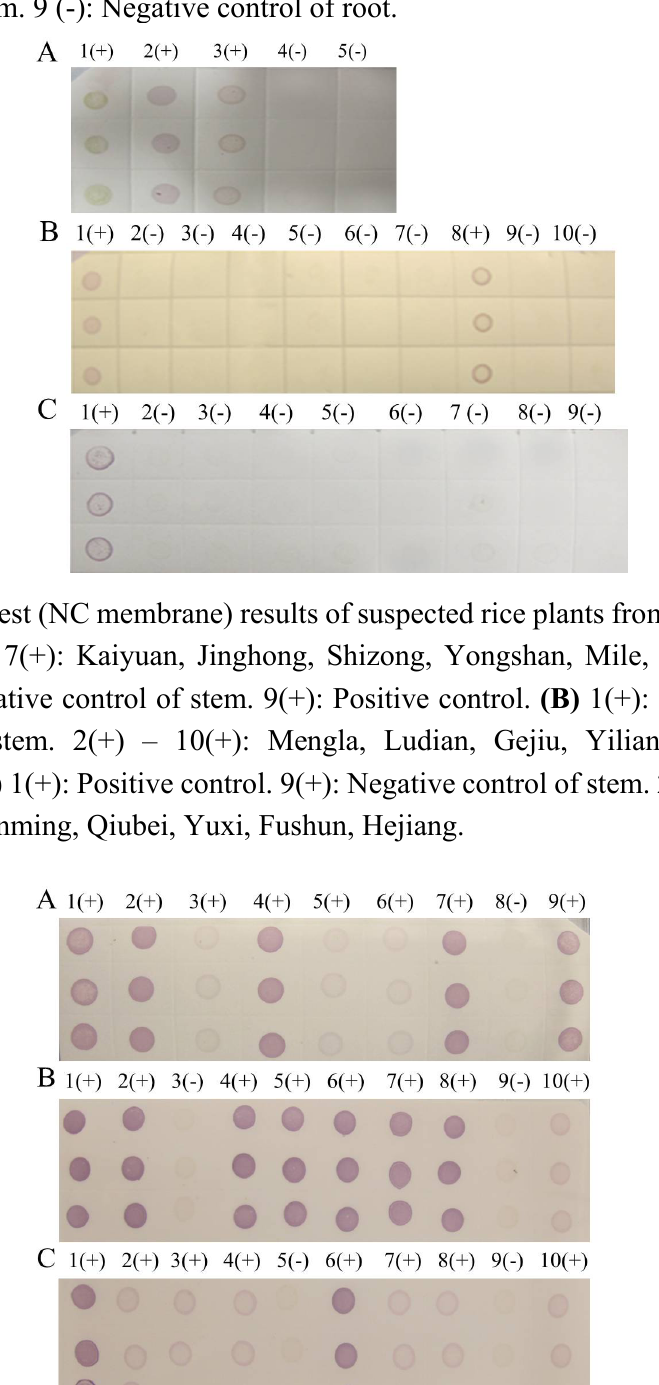
Figure 8. Dot-ELISA test (NC membrane) results of suspected rice plants. (A) Luodian of Guizhou Province. 1(+): Positive control. 2(+): Sample from Dongjia in Luodian. 3(+): Sample from Bianyang in Luodian. 4(-): Negative control of root. 5(-): Negative control of stem. (B) Jiajiang of Sichuan province and Dushan of Guizhou Province. 1(+): Positive control. 2(-) - 7(-): Stem of sample from Jiajiang. 8(+): Sample from Dushan. 9(-): Negative control of root. 10(-): Negative control of stem. (C) Kaiyang and Huishui of Guizhou Province. 1(+): Positive control. 2(-): Root of sample from Kaiyang. 3(-): Stem sample from Kaiyang. 4(-): Stem of sample I from Huishui. 5(-): Root of Sample I from Huishui. 6(-): Root of Sample II rom Huishui. 7(-): Stem of sample II from Huishui. 8(-):